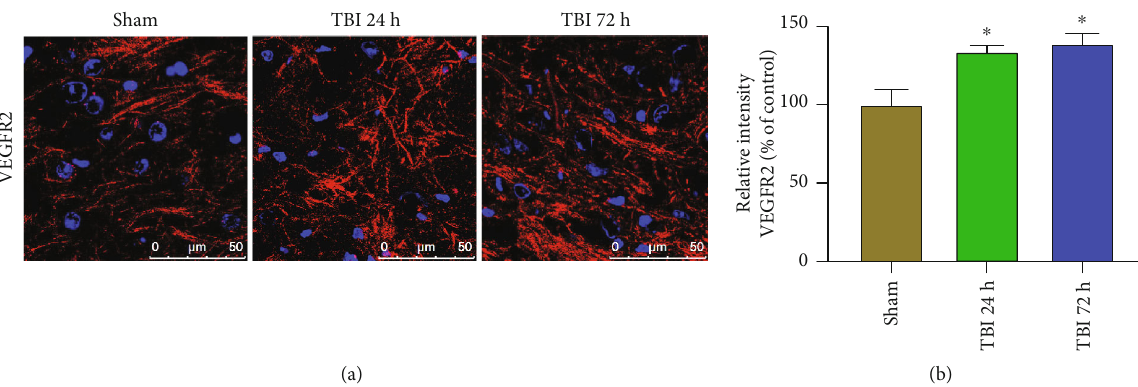
Figure 5: Acute TBI increases VEGFR2 expression in the brain. VEGFR2 expression was analyzed in the frozen sections (20 μ m) cut from the brains after 24 h and 72 h of weight drop model of TBI and sham control mouse brains without TBI ( n = 3 mice/group) by immuno fl uorescence staining. Representative images and immunoreactivity intensity bar graphs show increased VEGFR2 expression (red color) in 24 h and 72h acute TBI brains as compared with sham control brains without TBI ( ∗ p < 0 : 05 , sham control vs. TBI). The nuclei were stained with DAPI (blue color). Photomicrograph original magni fi